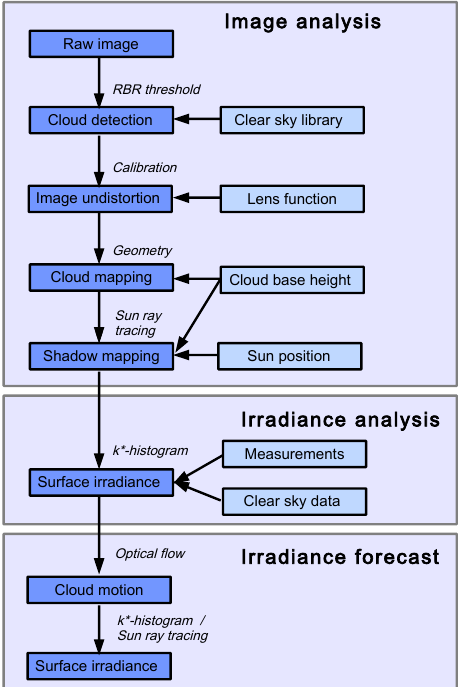
Figure 2. Sky imager analysis and forecast processing chain used in these